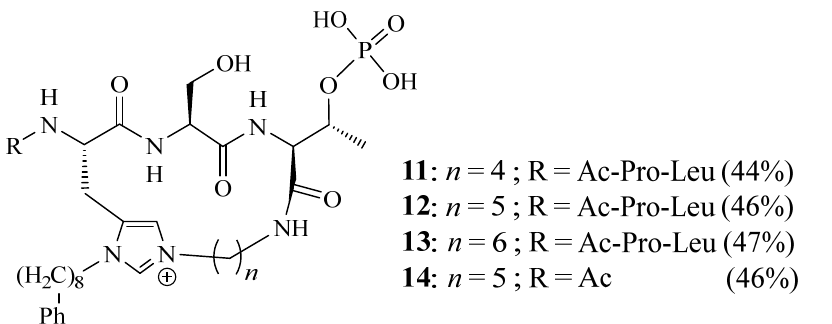
Figure 4. Structures of macrocycles 11 − 14. (Reprinted with permission from ref. [19]. Copyright 2018 Elsevier).